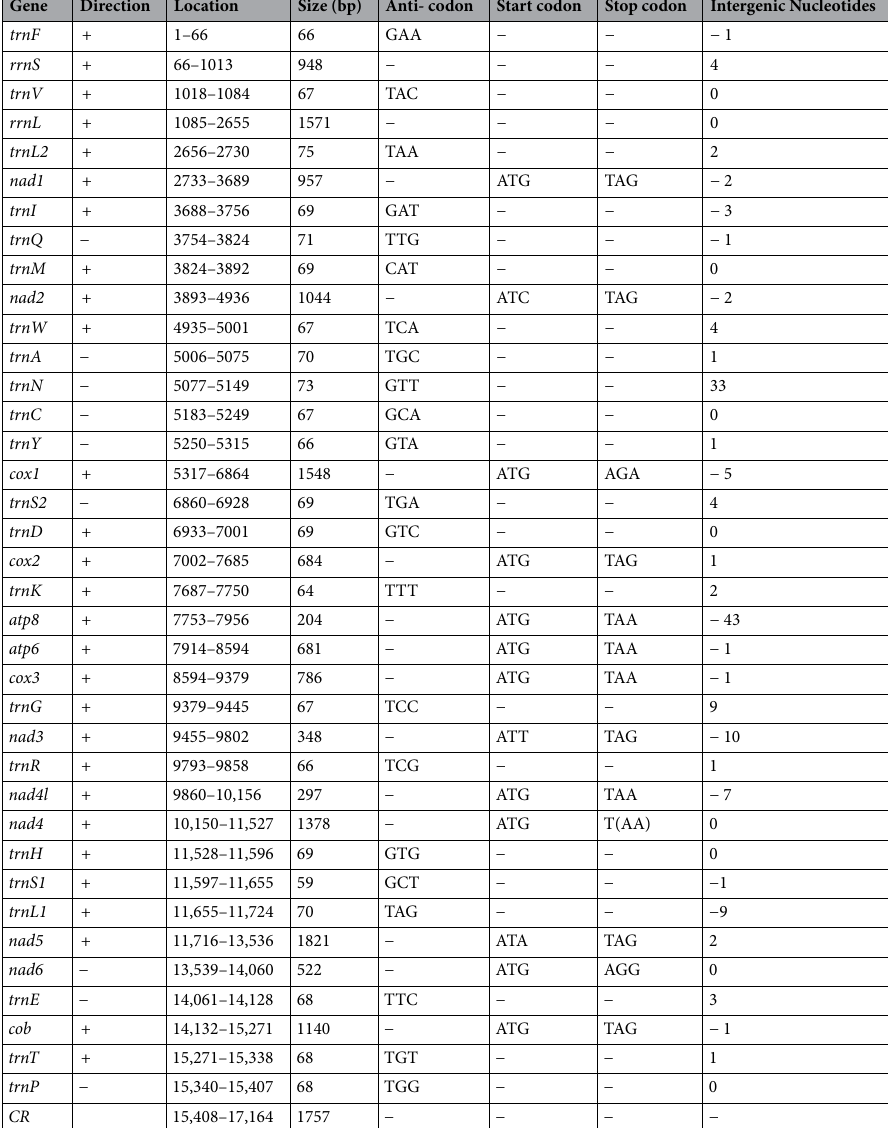
Table 1. List of annotated mitochondrial genes of the Nicobar treeshrew T. nicobarica